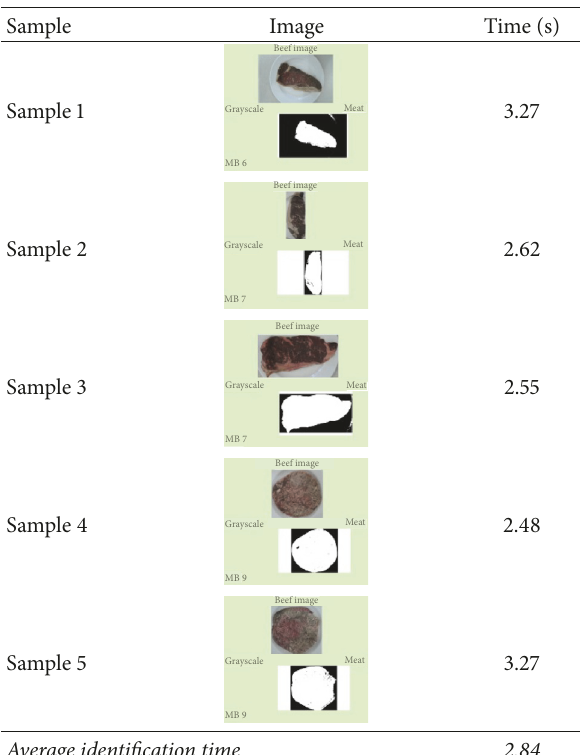
Table 7: Result of testing identification